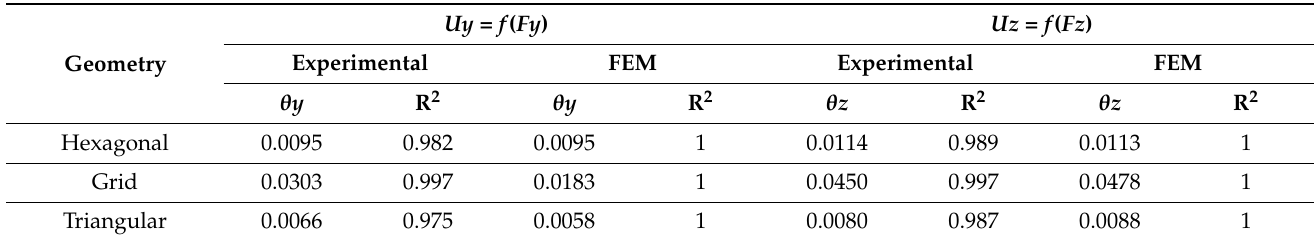
Table 3. The comparative analysis the tangents of the Uy = f ( Fy ) and Uz = f ( Fz ) functions obtained by experiment and the FEM simulation of three-point